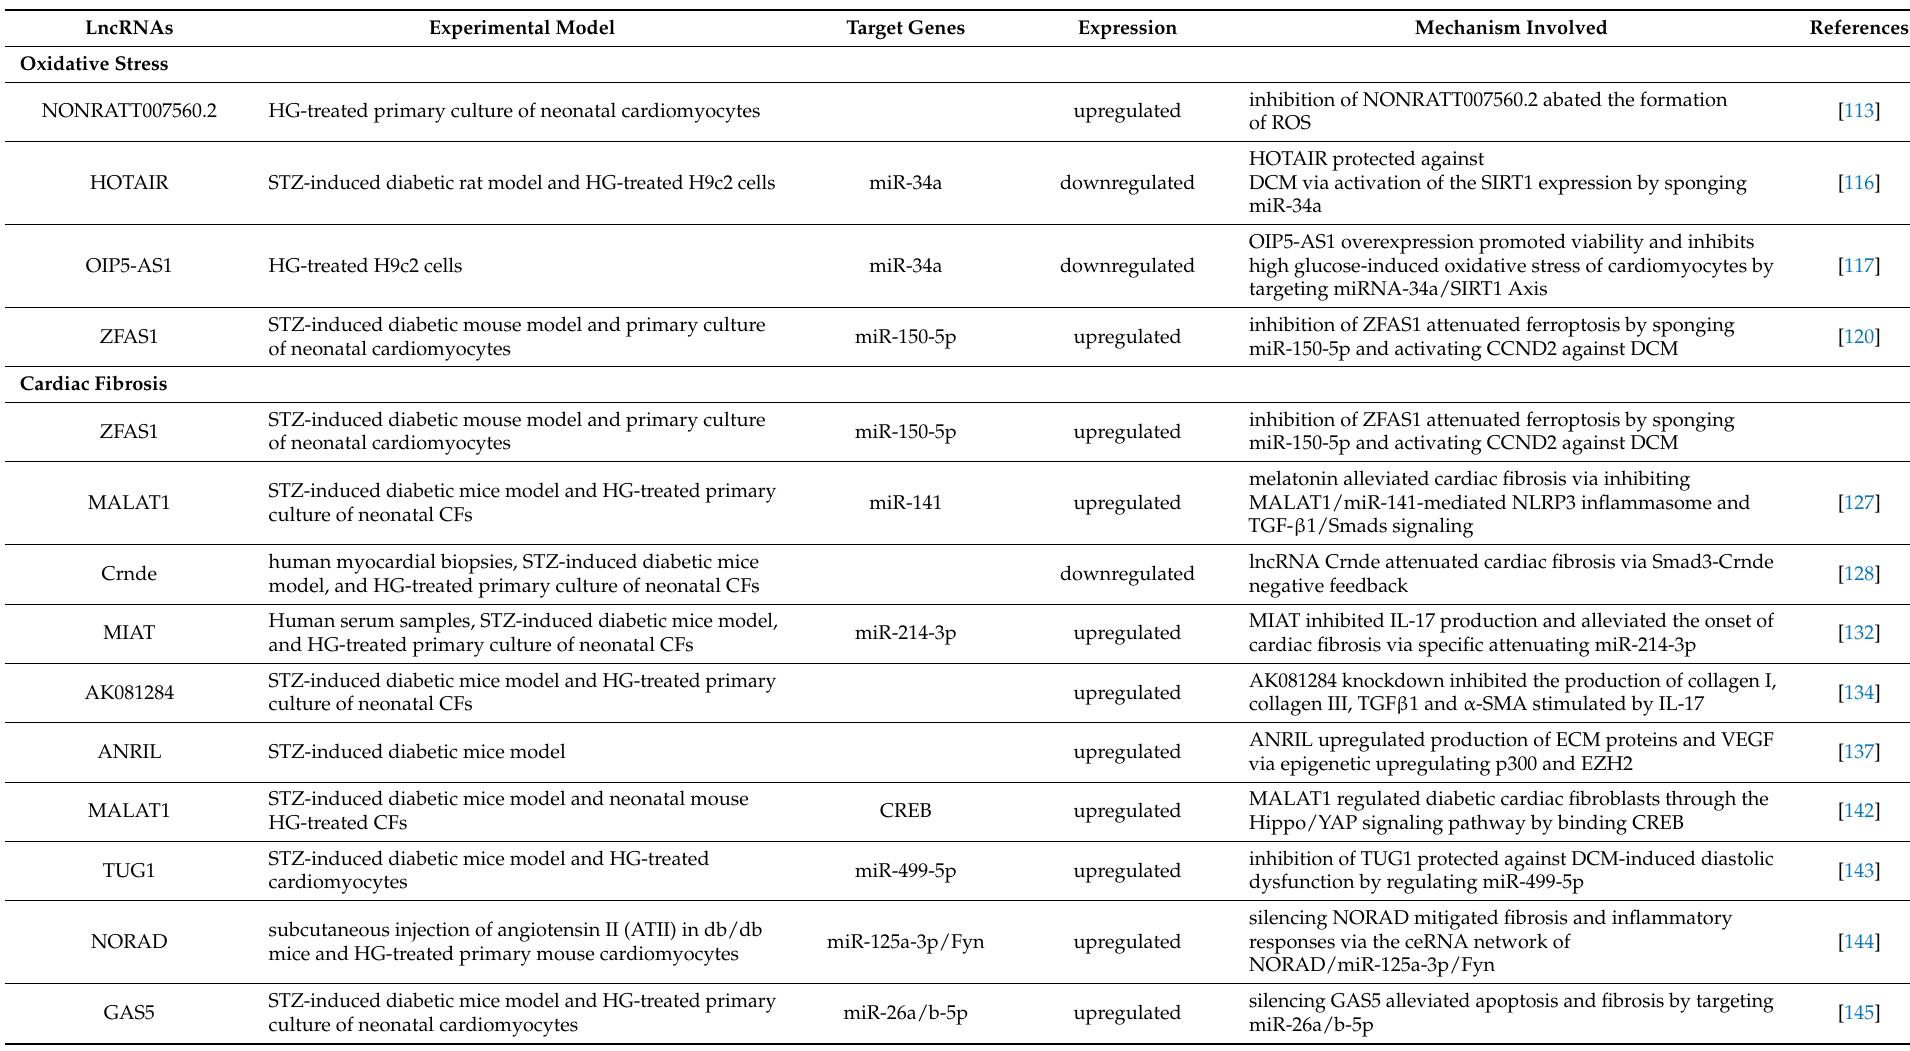
Table 3. LncRNAs implicated in the pathogenesis of oxidative stress and cardiac fibrosis in